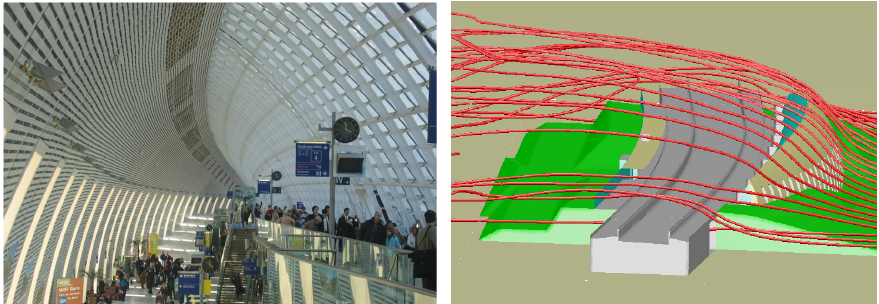
Figure 1: Interior space of the Avignon TGV Station. - Figure 2: Wind